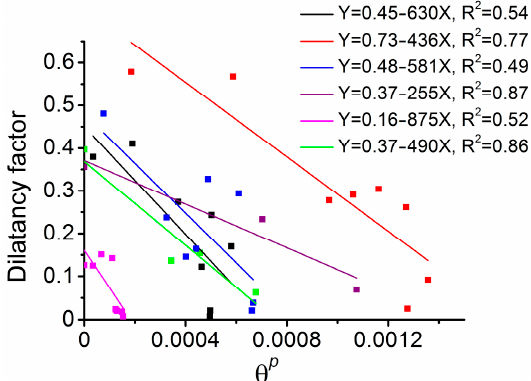
Figure A4. Determination of dilatancy factor curves of dependence on inelastic strain.